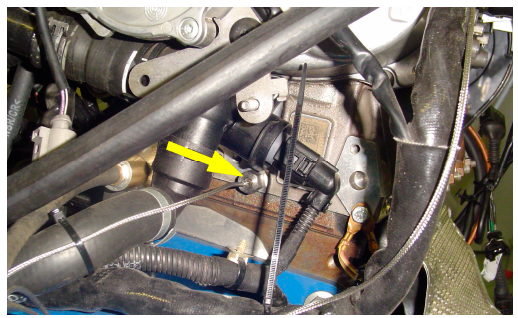
Figure 7. View of the combustion pressure sensor installed in the fired cylinder of the research engine (location of the sensor is indicated by the yellow arrow).